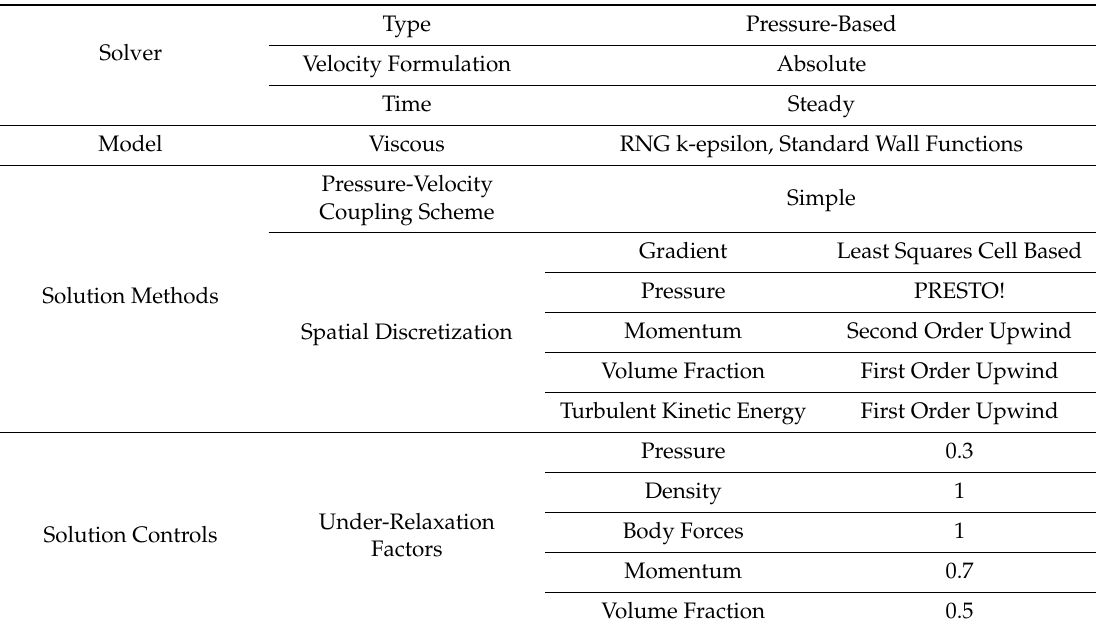
Table 2. [51]. Settings of the CFD analysis.